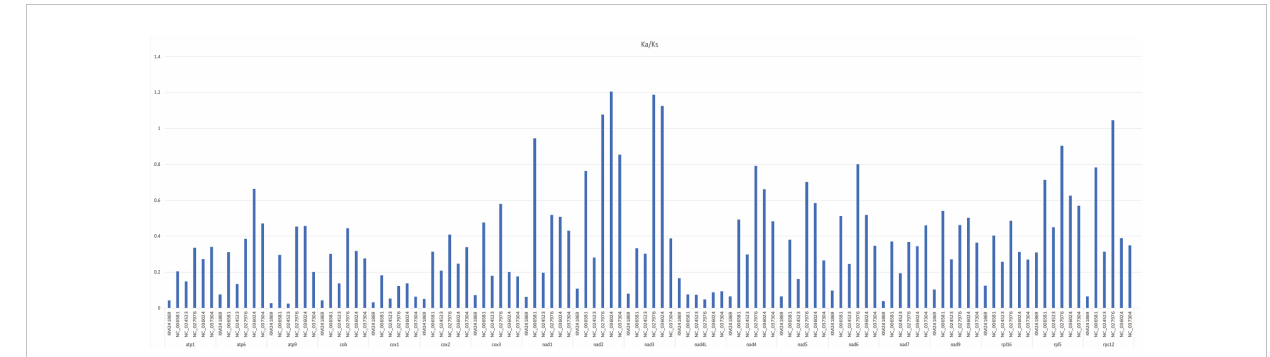
FIGURE 5 Ka/Ks of 18 similar protein-coding genes of A. of fi cinalis versus six species. Deep gray and light gray boxes indicate Ka/Ks ratio of A. of fi cinalis versus Chlorella sorokiniana, Nicotiana tabacum , Funaria hygrometrica , Ginkgo biloba , Triticum aestivum, Arabidopsis thaliana , respectively.